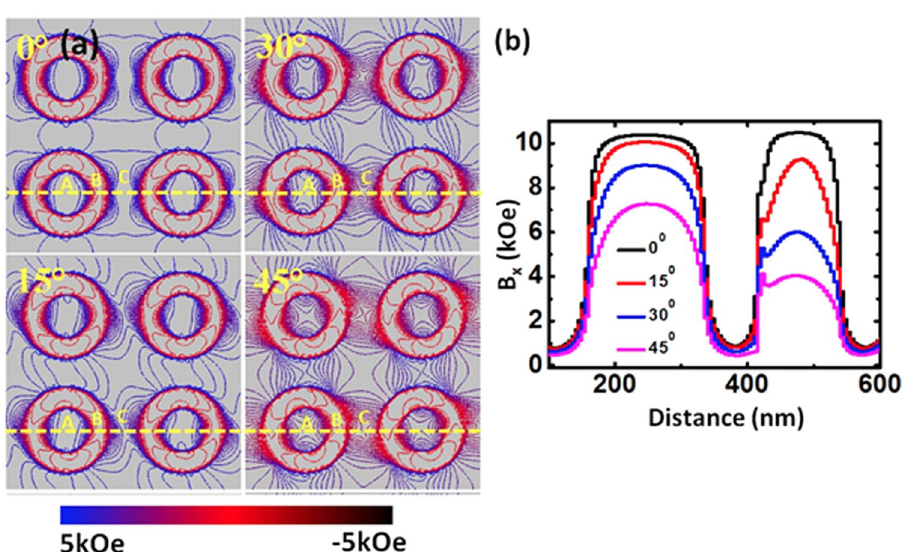
Figure 6. ( a ) Contour maps of simulated magnetostatic field distributions for different orientation of the in- plane bias magnetic field of the sample. The strength of the stray field is represented by the color map at the bottom of the figure. ( b ) Comparison of the simulated magnetostatic field components B x for specific ϕ taken along the dotted yellow lines from the